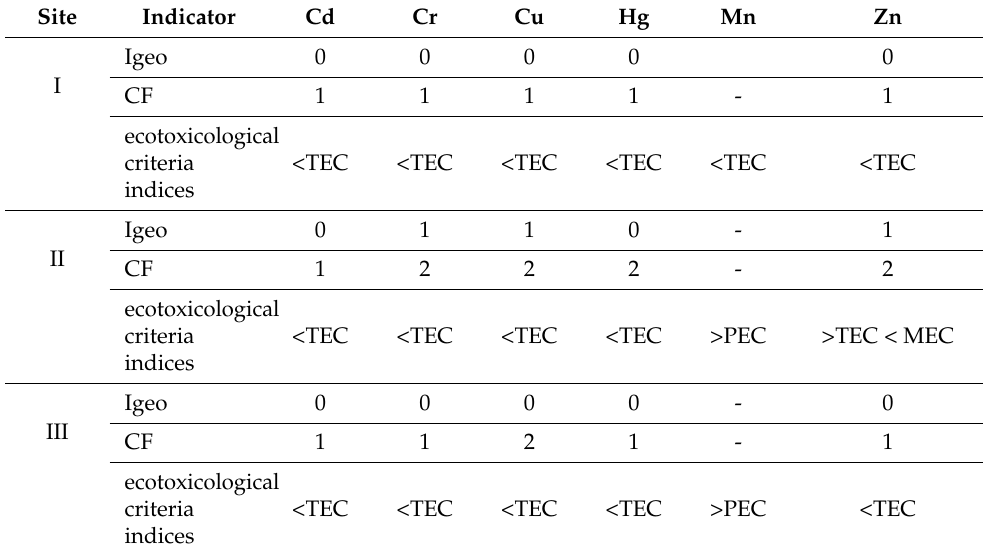
Table 4. Sediment contamination classes according to geochemical index (Igeo) and contamination factor (CF) indicators and to ecotoxicological criteria